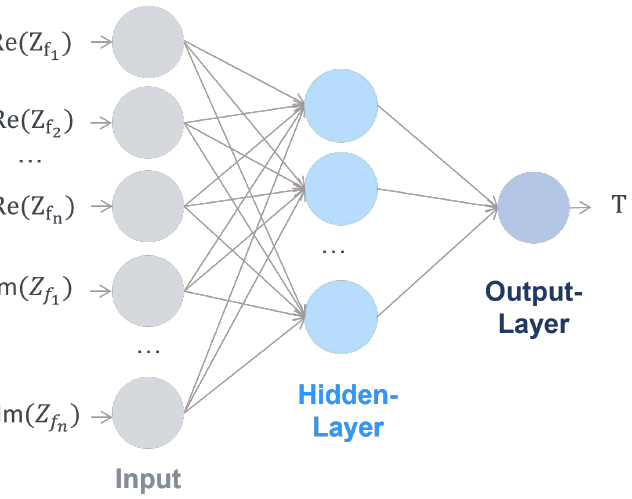
Figure 6. Schematic figure of the used artificial neural network. The real and/or imaginary part of the impedance measurement is used as the input The used ANN is subcategorized into three main layers: input layer, hidden layer and output layer. Each neuron is connected with a neuron at the following layer in the forward direction. In the context of this work, the number of hidden layers was limited to a single layer. When the number of hidden layers used is more than one, the network is a deep neural network. Within the layer, the number of neurons was varied. In order to determine the optimal number of neurons, a grid search approach was used, where the number of neurons was continually increased until the prediction accuracy was no longer improving without restricting the generalization ability. The number of neurons within the hidden layer is presented in the discussion for each investigated case separately. In the hidden layers, a hyperbolic tangent sigmoid transfer function is used, which is given